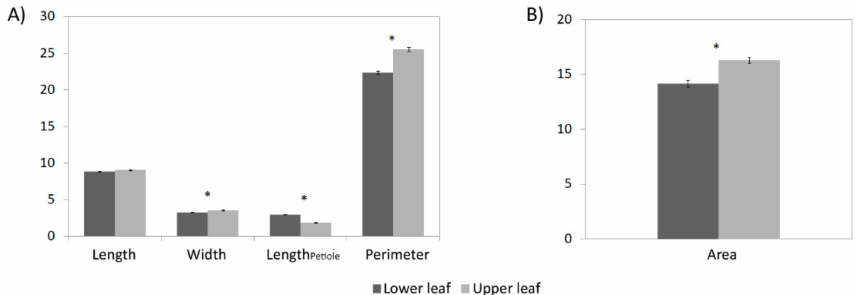
Figure 3. Mean values ± SE ( n = 220) for size-related traits measured in the lower and upper leaves. ( A ) Comparison between lower and upper leaves for length, width, and the length of the petiole and perimeter (cm). ( B ) Comparison between the lower and upper leaves for area (cm 2